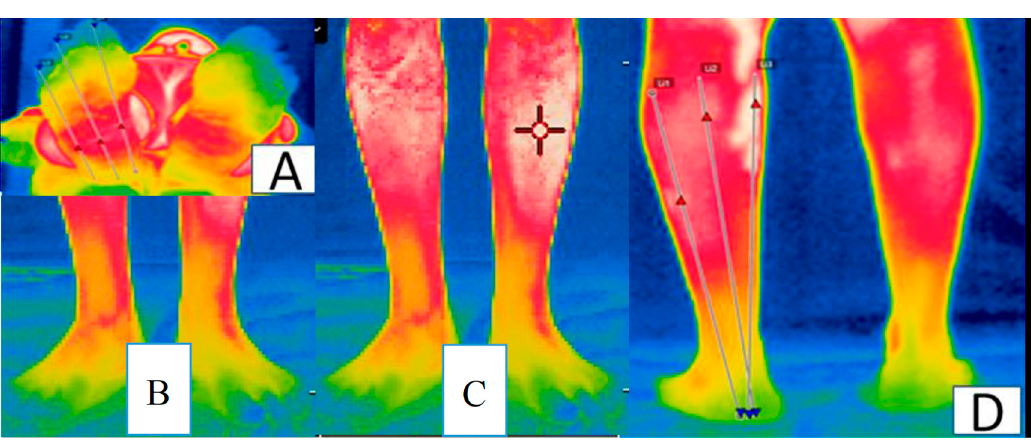
Figure 1. Regions of interest for infrared thermographic imaging: ( A ) sole of the feet; ( B ) back of the feet; ( C ) anterior leg; ( D ) back of the legs.